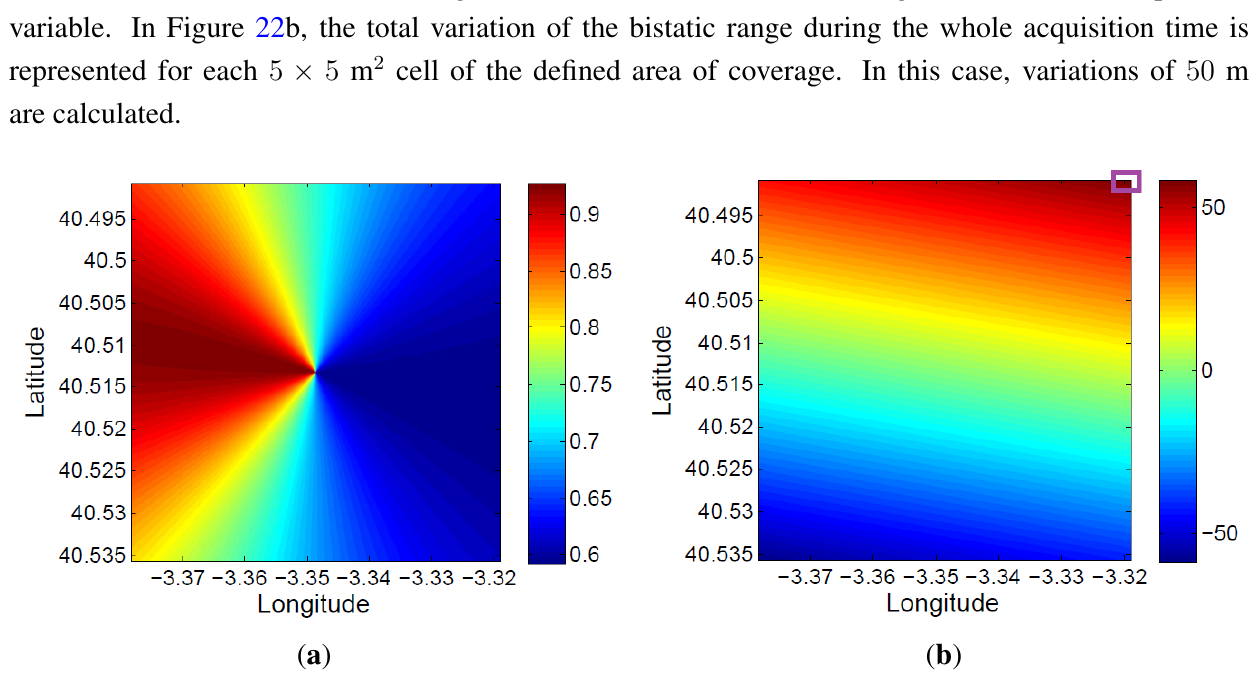
Figure 22. Bistatic range resolution and bistatic range: ( a ) initial bistatic range resolution at each 5 × 5 m 2 cell of the coverage area; ( b ) total variation of the bistatic range during the acquisition time.